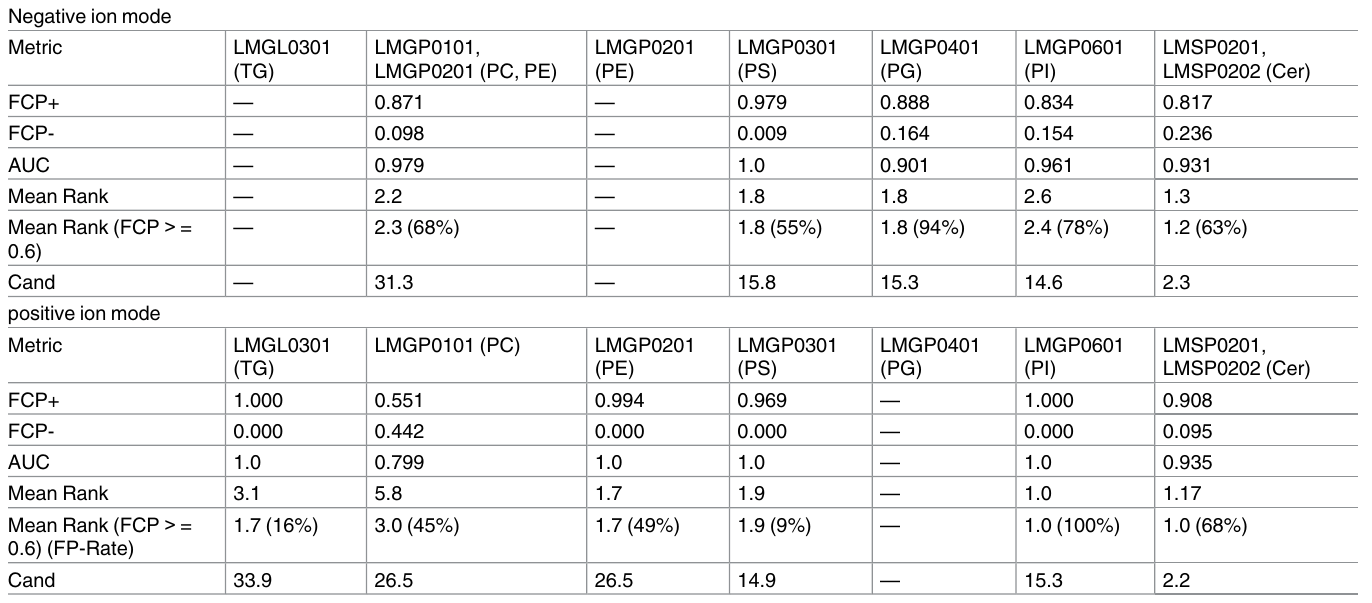
Table 1. Results of the MetFrag identification and the classifier testing.